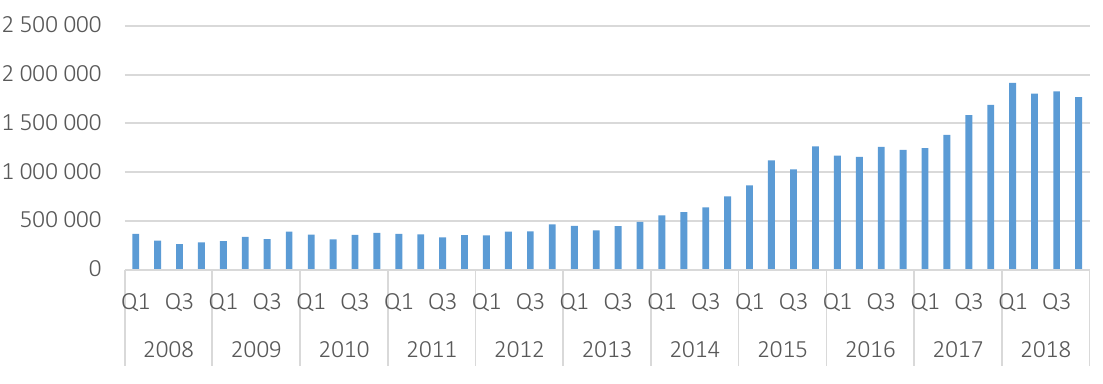
Figure 2. Total net assets (USD